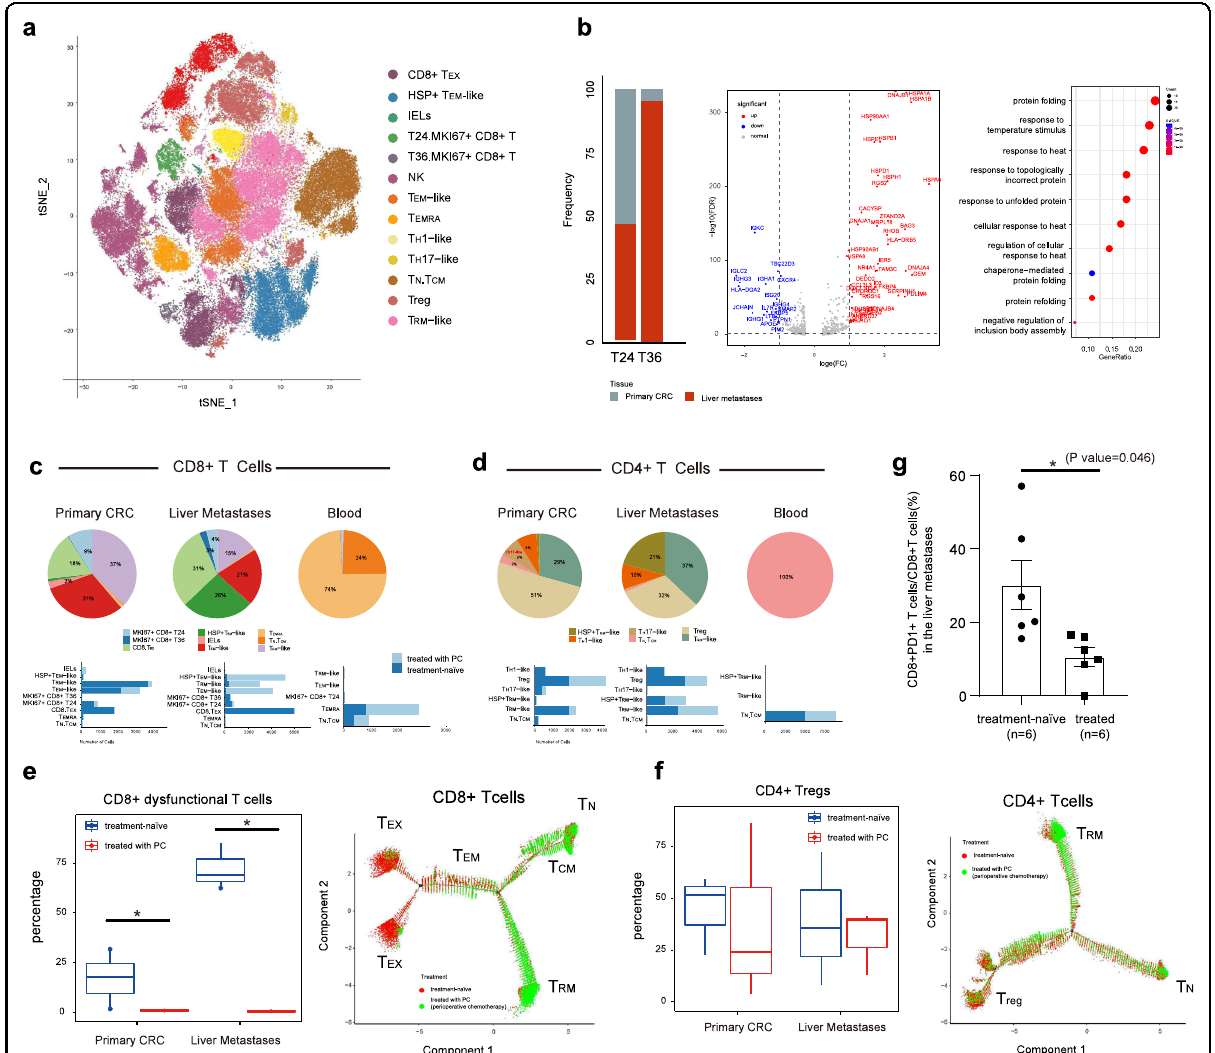
Fig. 5 Cell subpopulations in the T cell compartment. a t-SNE plot showing a total of 86,803 cells classi fi ed into T/NK cell subtypes. b Bar plot exhibiting the distribution of T24 and T36 cells across different tissues (left). Volcano plot showing DEGs between the T24 and T36 clusters (middle). Each red/blue dot denotes an individual gene with fold change ≥ 2 and adjusted P value < 0.01 (two-sided moderated t -test with limma). GO analysis of DEGs between T24 and T36 (right). Selected GO terms with Benjamini-Hochberg-corrected P values < 0.05 (one-sided Fisher ’ s exact test) are shown. Bottom, based on the annotation and classi fi cation above, bar plots depicting cell numbers of each subtype of CD8 + T cells ( c ) and CD4 + T cells ( d ) in tumors with or without PC treatment are shown. Top, pie charts showing the proportions of different T cell subtypes within different tissues (the primary CRC, liver metastases, and blood). Left, frequencies of CD8 + dysfunctional T cells ( e ) and Tregs ( f ) in primary CRC and liver metastases with or without PC treatment are shown, respectively. Wilcoxon rank-sum test was used for statistical analysis. * P < 0.05. Developmental trajectory analysis of CD8 + T cells ( e ) and CD4 + T cells ( f ). Cells are colored according to the treatment states. g The FACS results showing the ratio of PD-1 + CD8 + T cells to CD8 + T cells in liver metastases of CRC patients treated with or without